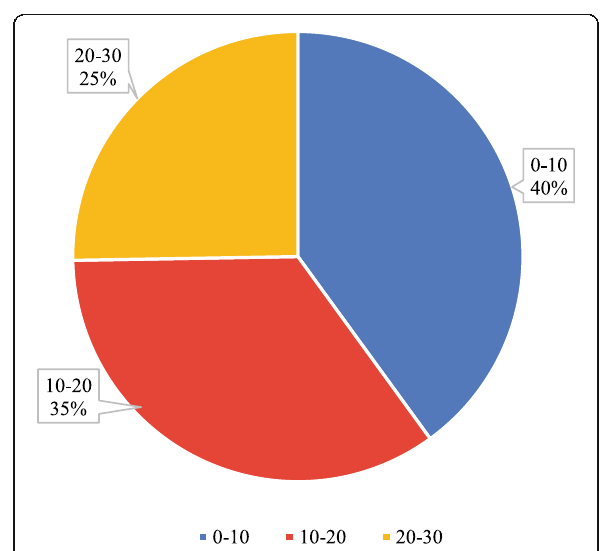
Fig. 4 The average number of CT scan cases per duty witnessed by the